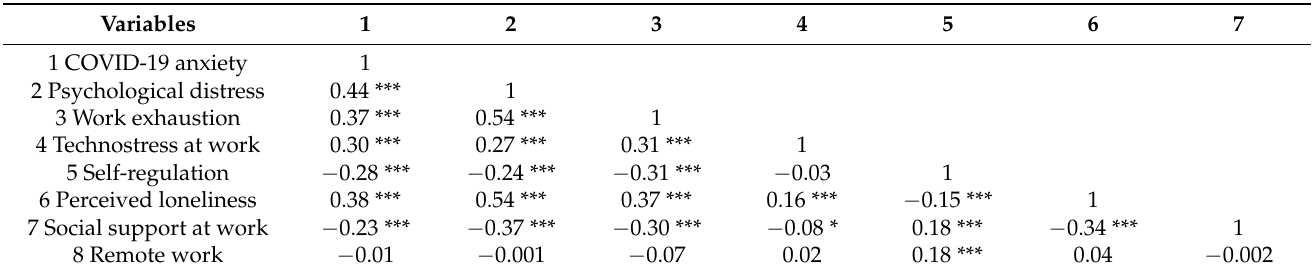
Table 2. Zero-order correlations at T1.